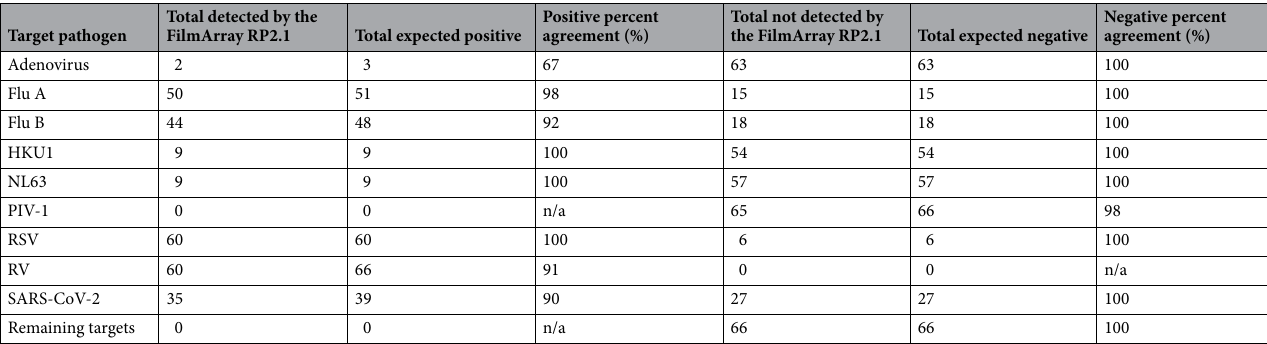
Table 1. Performance of the FilmArray RP2.1 Test panel for each pathogen target from pooled clinical